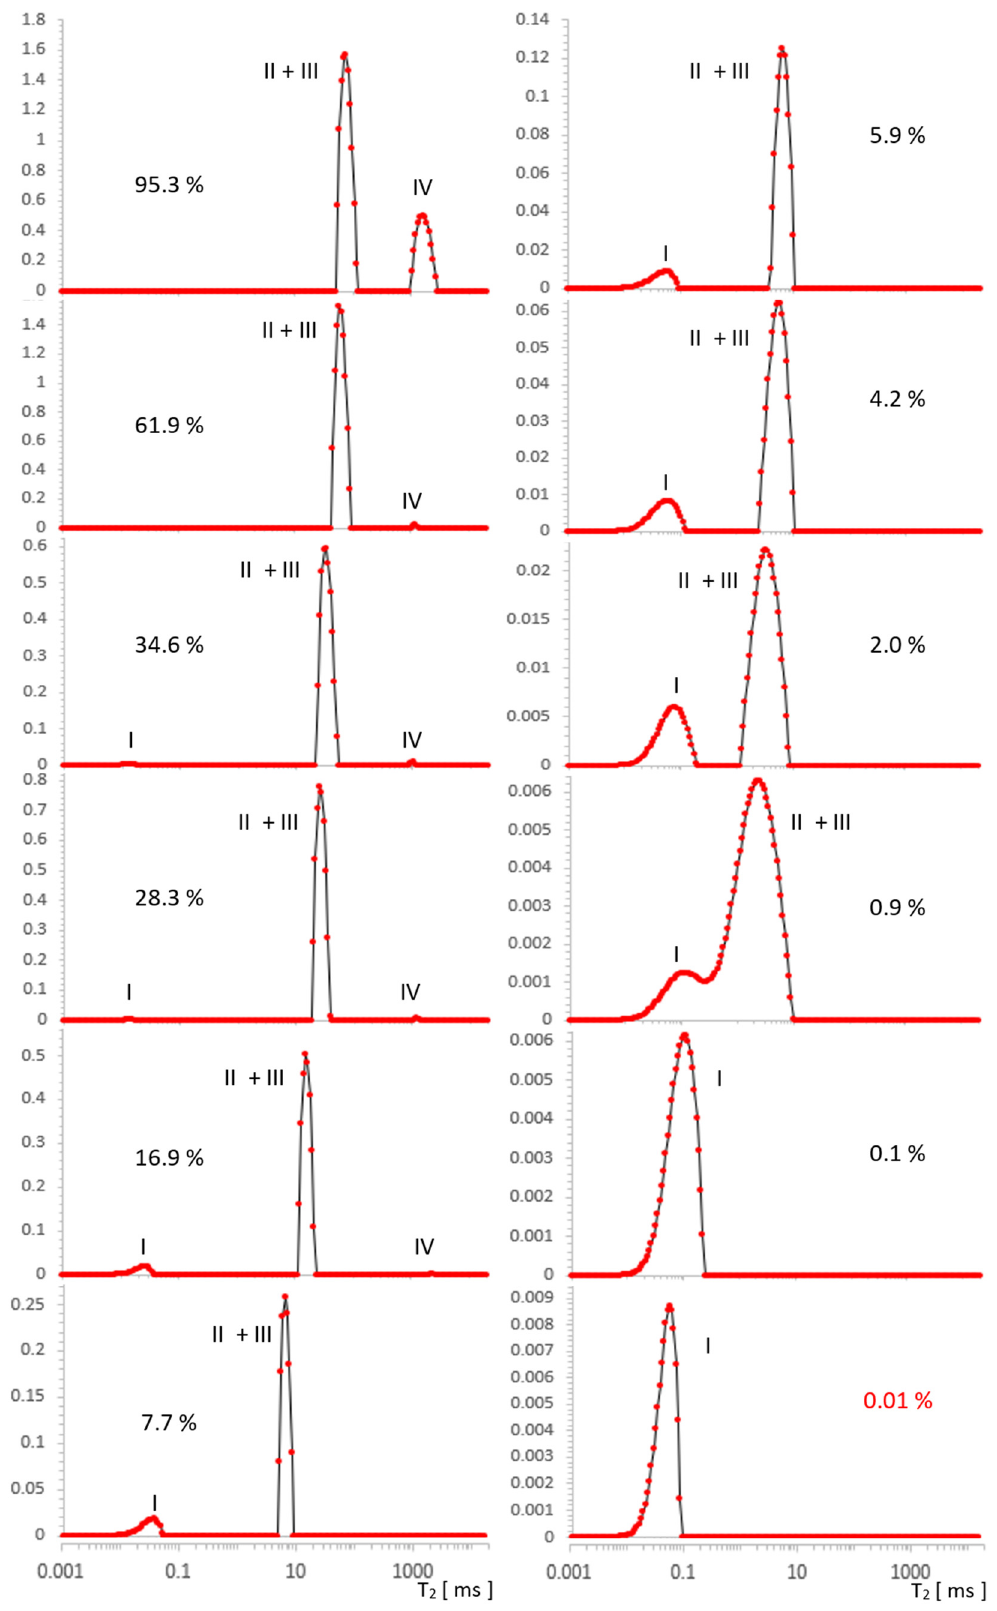
Figure 4. Evolution of the T 2 spectrum for SBA-15, obtained in [a.u.] using ILT transform, along a series of water saturations. I—OH groups, II—intra pore water, III—inter pore water, IV—free water. The vertical axes represent the values of the ILT transform in [a.u.] units.